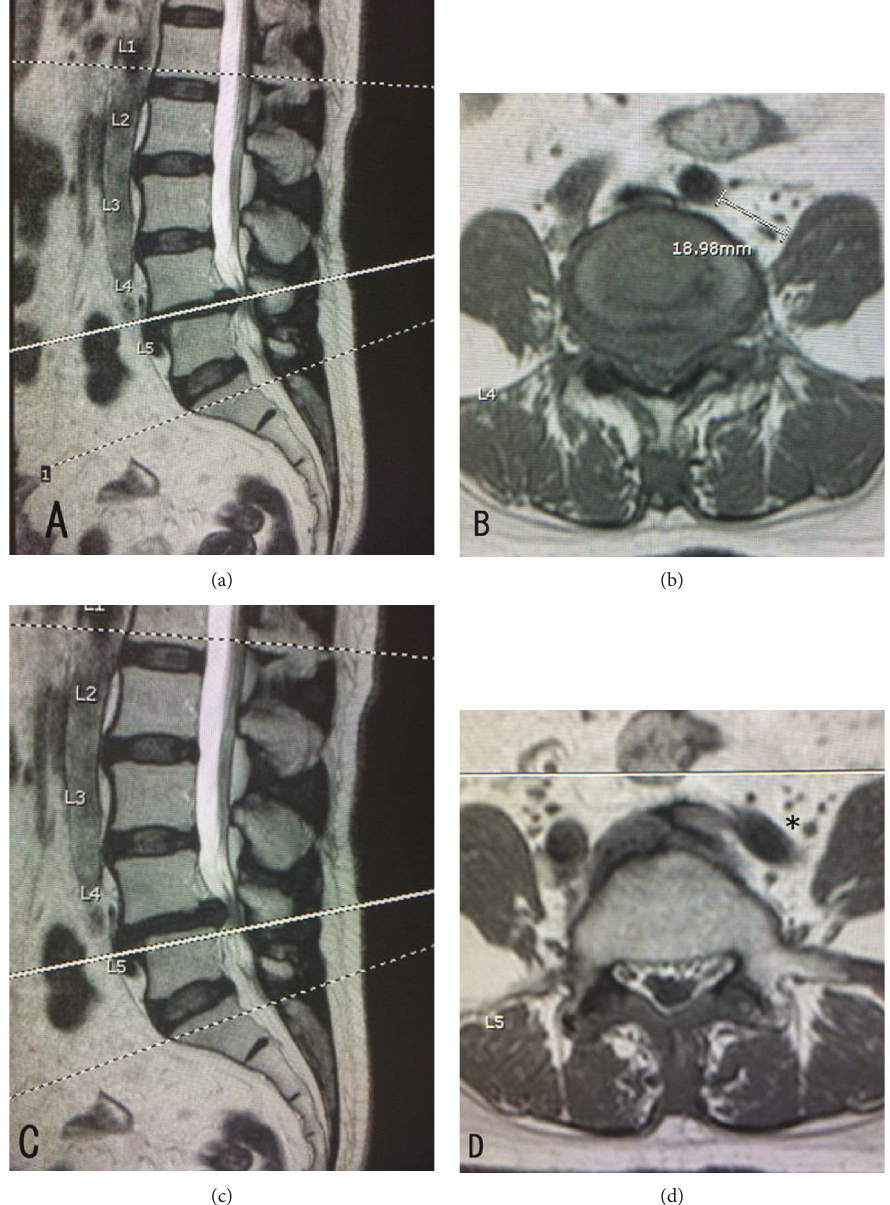
Figure 1: Preoperative MRI of lumbosacral spine T1W image showed prepsoas corridor at the level of intervertebral disc space L4-L5 (a and b) and at the level of upper vertebral body of L5 (c and d). Rising of psoas muscle was shown in (d). Left common iliac artery almost obliterates prepsoas space at level of upper vertebral body of L5 (black